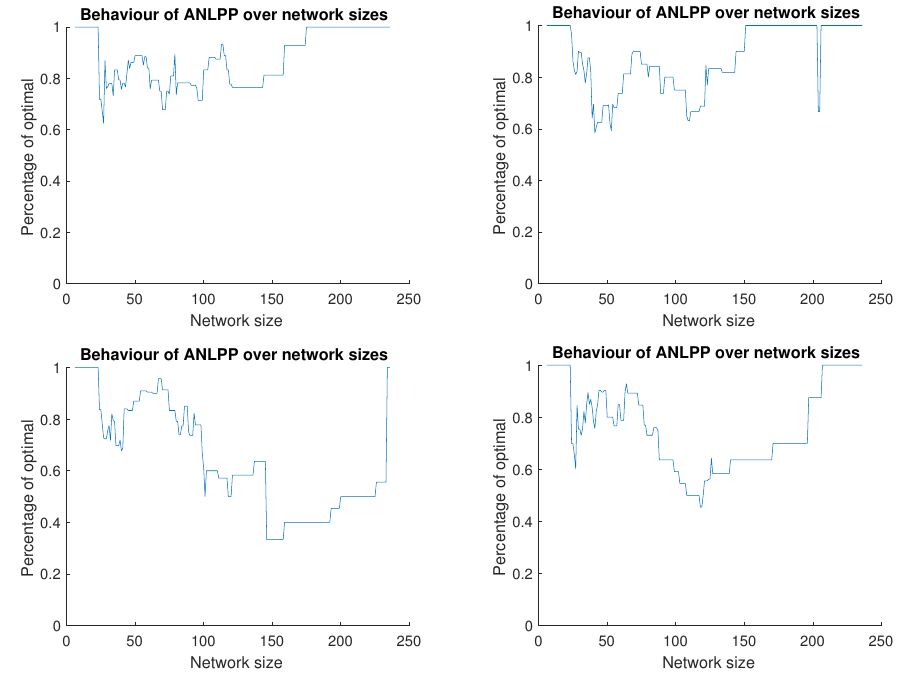
Figure 4. All Network Least Possible Probability (ANLPP) behaviour on four random networks with the same parameters, ANLPP tuned for maximum size. All cases starting and ending with optimal life increase for the maximum size of the network, while having different behaviours in